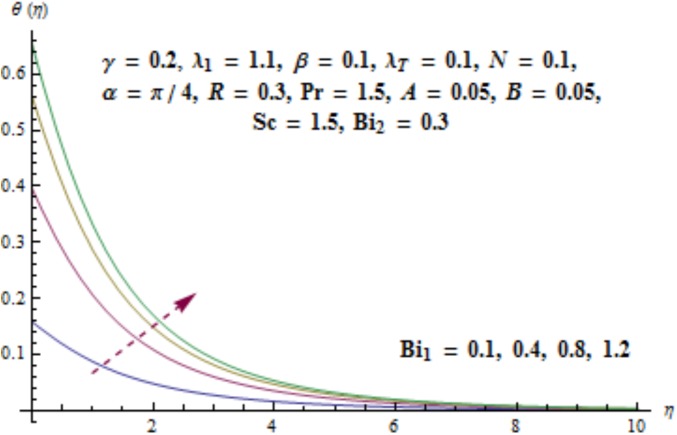
Behavior of Bi1 on θ(η).